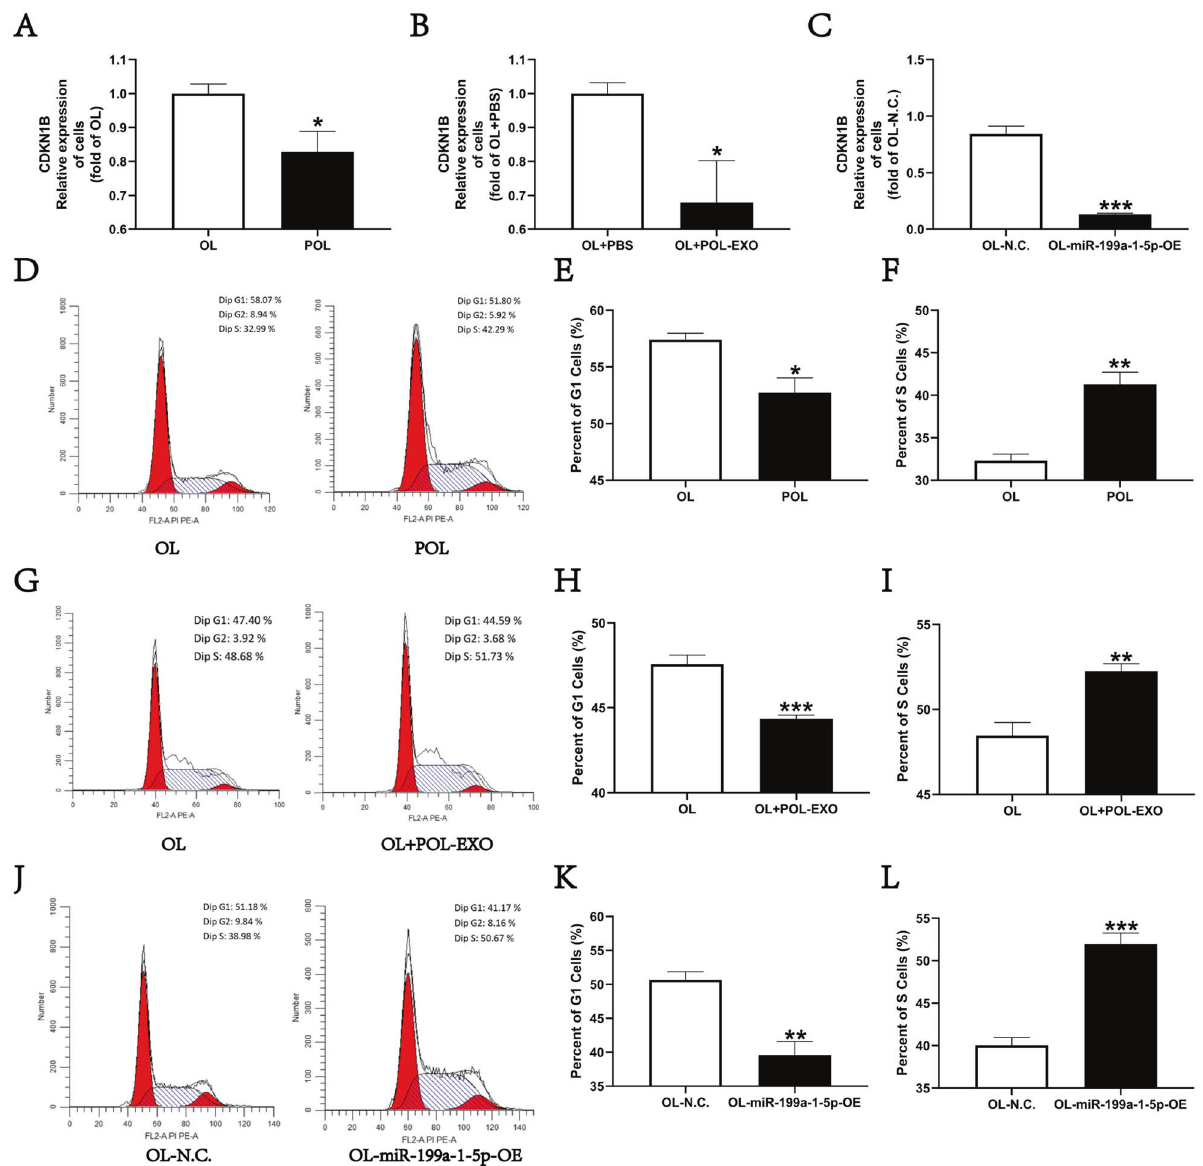
Fig. 5 miR-199a-1-5p reduces the expression level of CDKN1B and promotes the cell-cycle transition. CDKN1B gene expression in OL and POL cells ( A , * P < 0.05), in OL + PBS and OL + POL-exo ( B , * P < 0.05) and in OL-N.C. and POL-miR-199a-1-5p-OE cells ( C , *** P < 0.001) evaluated by RT-qPCR. D Analysis of changes in cell cycle transition between OL and POL cells. The number of G1 phase ( E , * P < 0.05), S phase ( F , ** P < 0.01) cells in OL and POL cells. G Analysis of changes in cell cycle transition between OL and OL + POL-Exo. The number of G1 phase ( H , *** P < 0.001) and S phase ( I , ** P < 0.01) cells in OL and OL + POL-Exo. J Analysis of changes in cell cycle transition between OL-N.C. and OL-miR-199a- 1-5p-OE cells. The number of G1 phase ( K , ** P < 0.01) and S phase ( L , *** P < 0.001) cells in OL-N.C. and OL-miR-199a-1-5p-OE